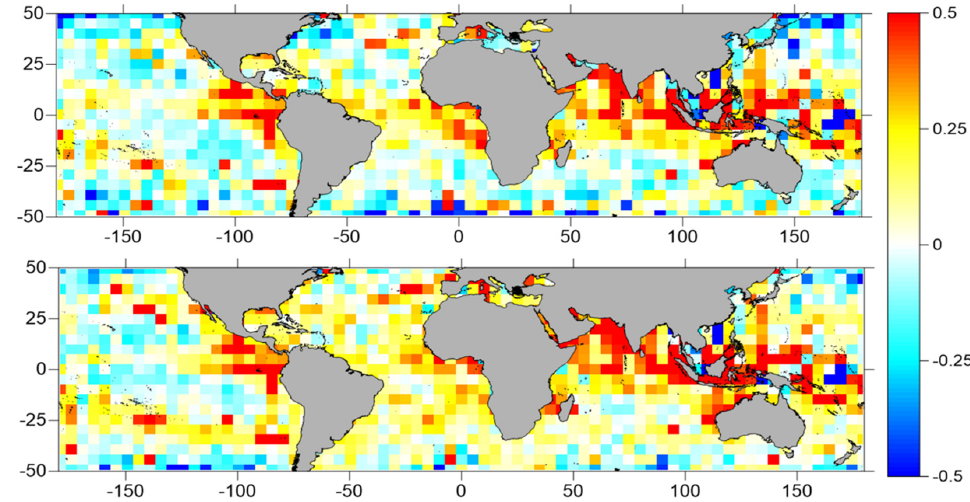
Figure 9. Differences, in cm, between RMS values for Op. 5I NN—Algorithm 2 ( top panel), and Op. 5I NN—Algorithm 4 ( bottom panel), represented with a 5° by 5° spatial resolution.